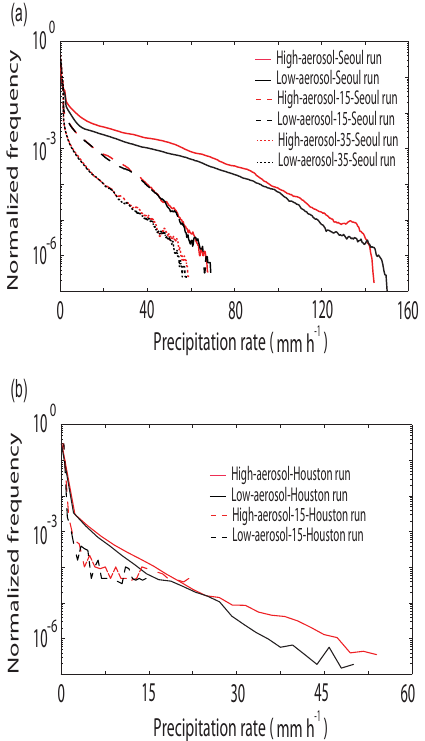
Figure 11. Same as Fig. 8, but for evaporation rates.